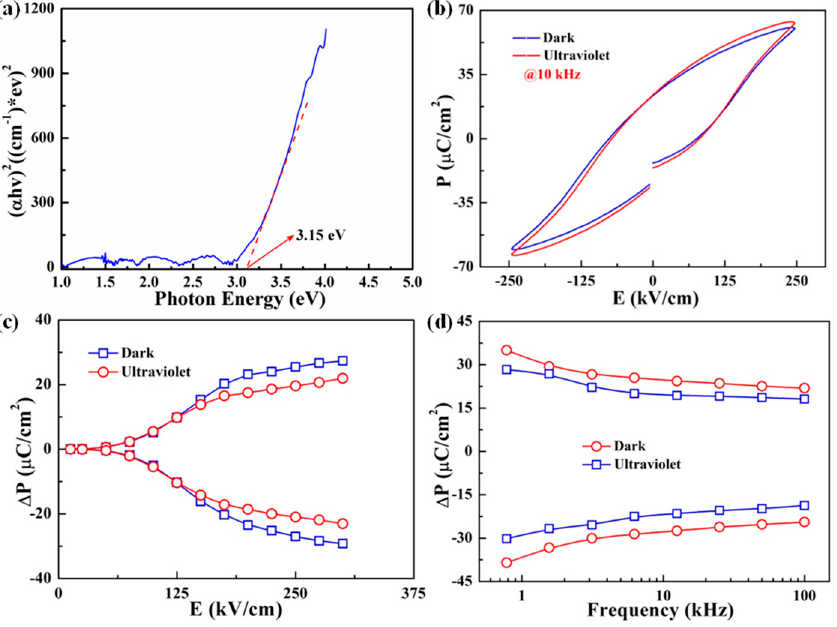
Figure 5. Forbidden gap ( a ), hysteresis loops ( b ), electric field-dependence ( c ) and frequency-dependence ( d ) of Δ P for Pt/NBT/LSCO capacitor under ultraviolet light.